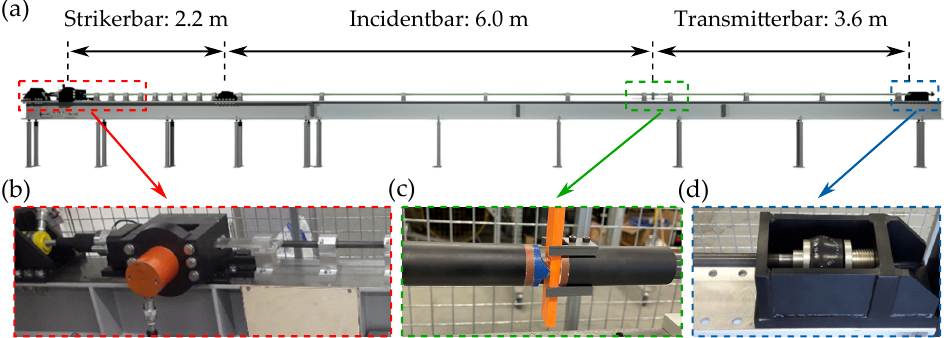
Figure 2. Overview and detailed sections of the split Hopkinson test bench: ( a ) Overview of the SHPB test bench. ( b ) Striker bar with hydraulic and release mechanism to initiate the shock wave. ( c ) Immediate test area with the busbar specimen. ( d ) Damping element in order to absorb excess